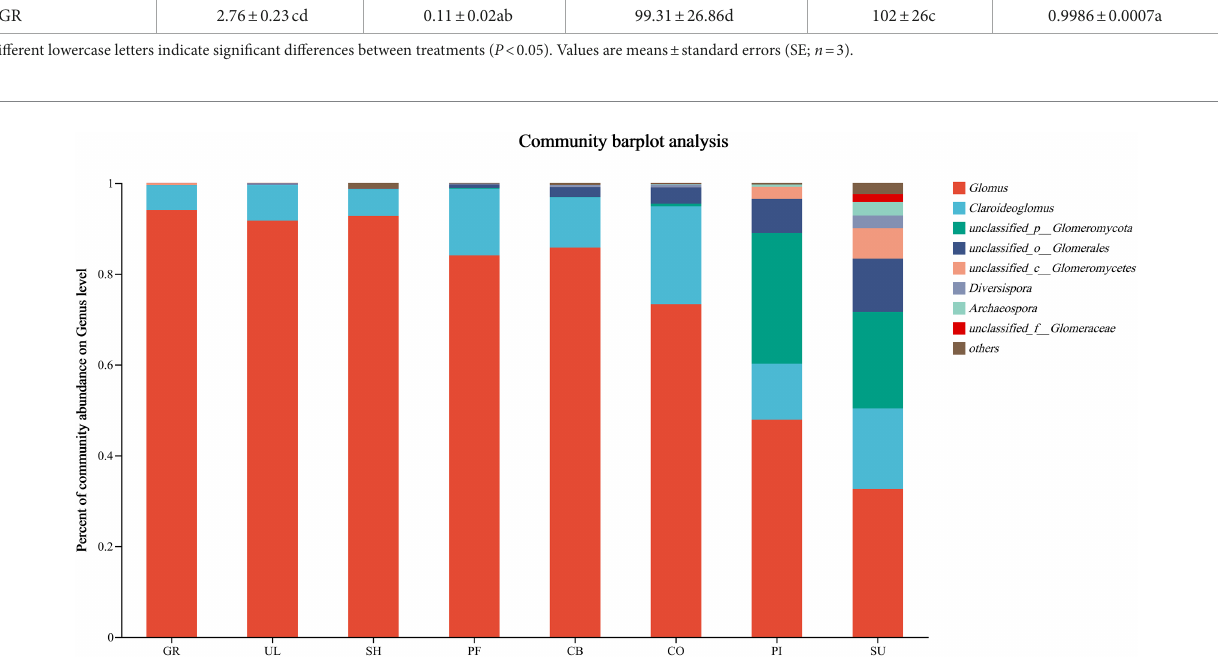
FIGURE 2 Genus level composition of AMF communities in soil at different